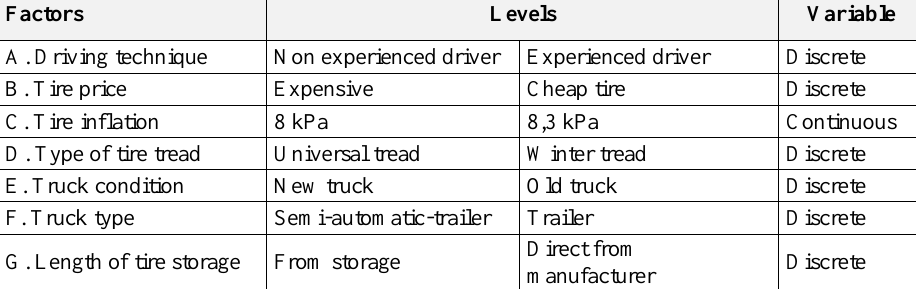
Table 2 – Factors selected for screening experiment Factors